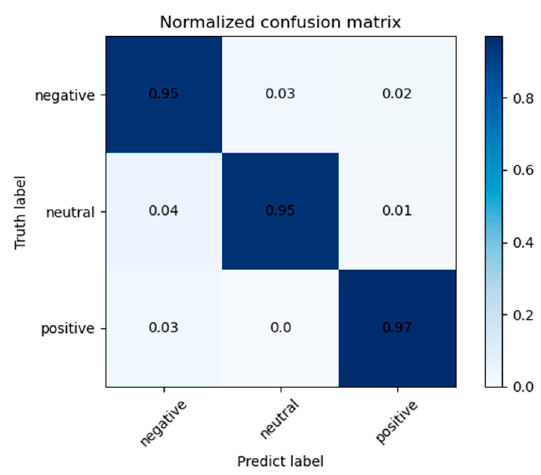
Figure 9. Confusion matrix for LOSO cross-validation.